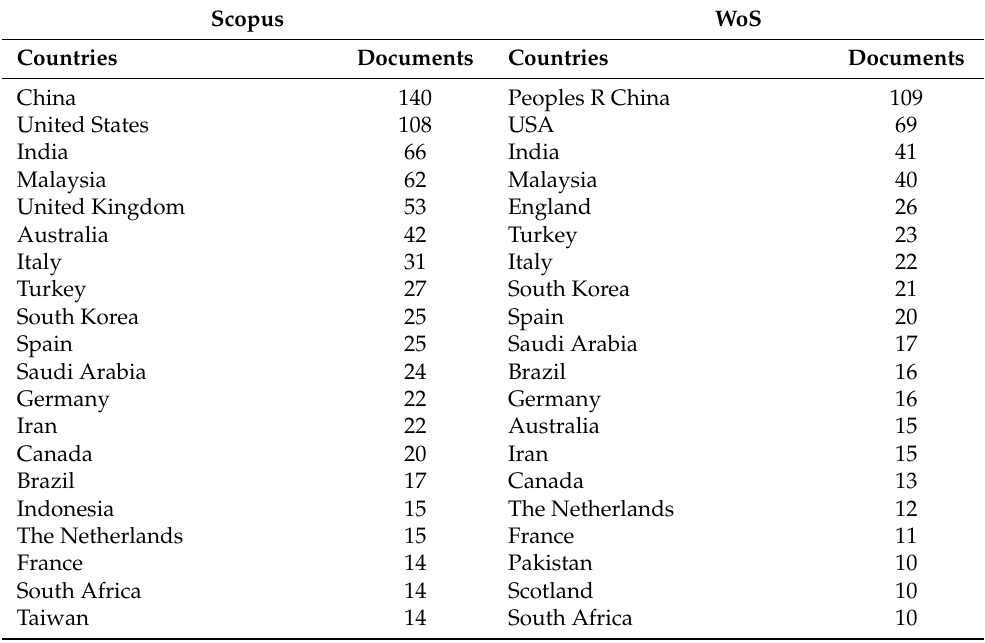
Table 2. Top-20 networked countries from Scopus and WoS databases for bibliographic coupling links. Scopus WoS Countries